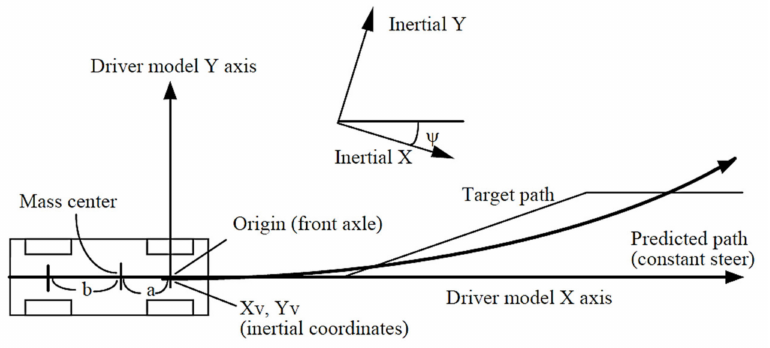
Figure 3. Axis system of steering